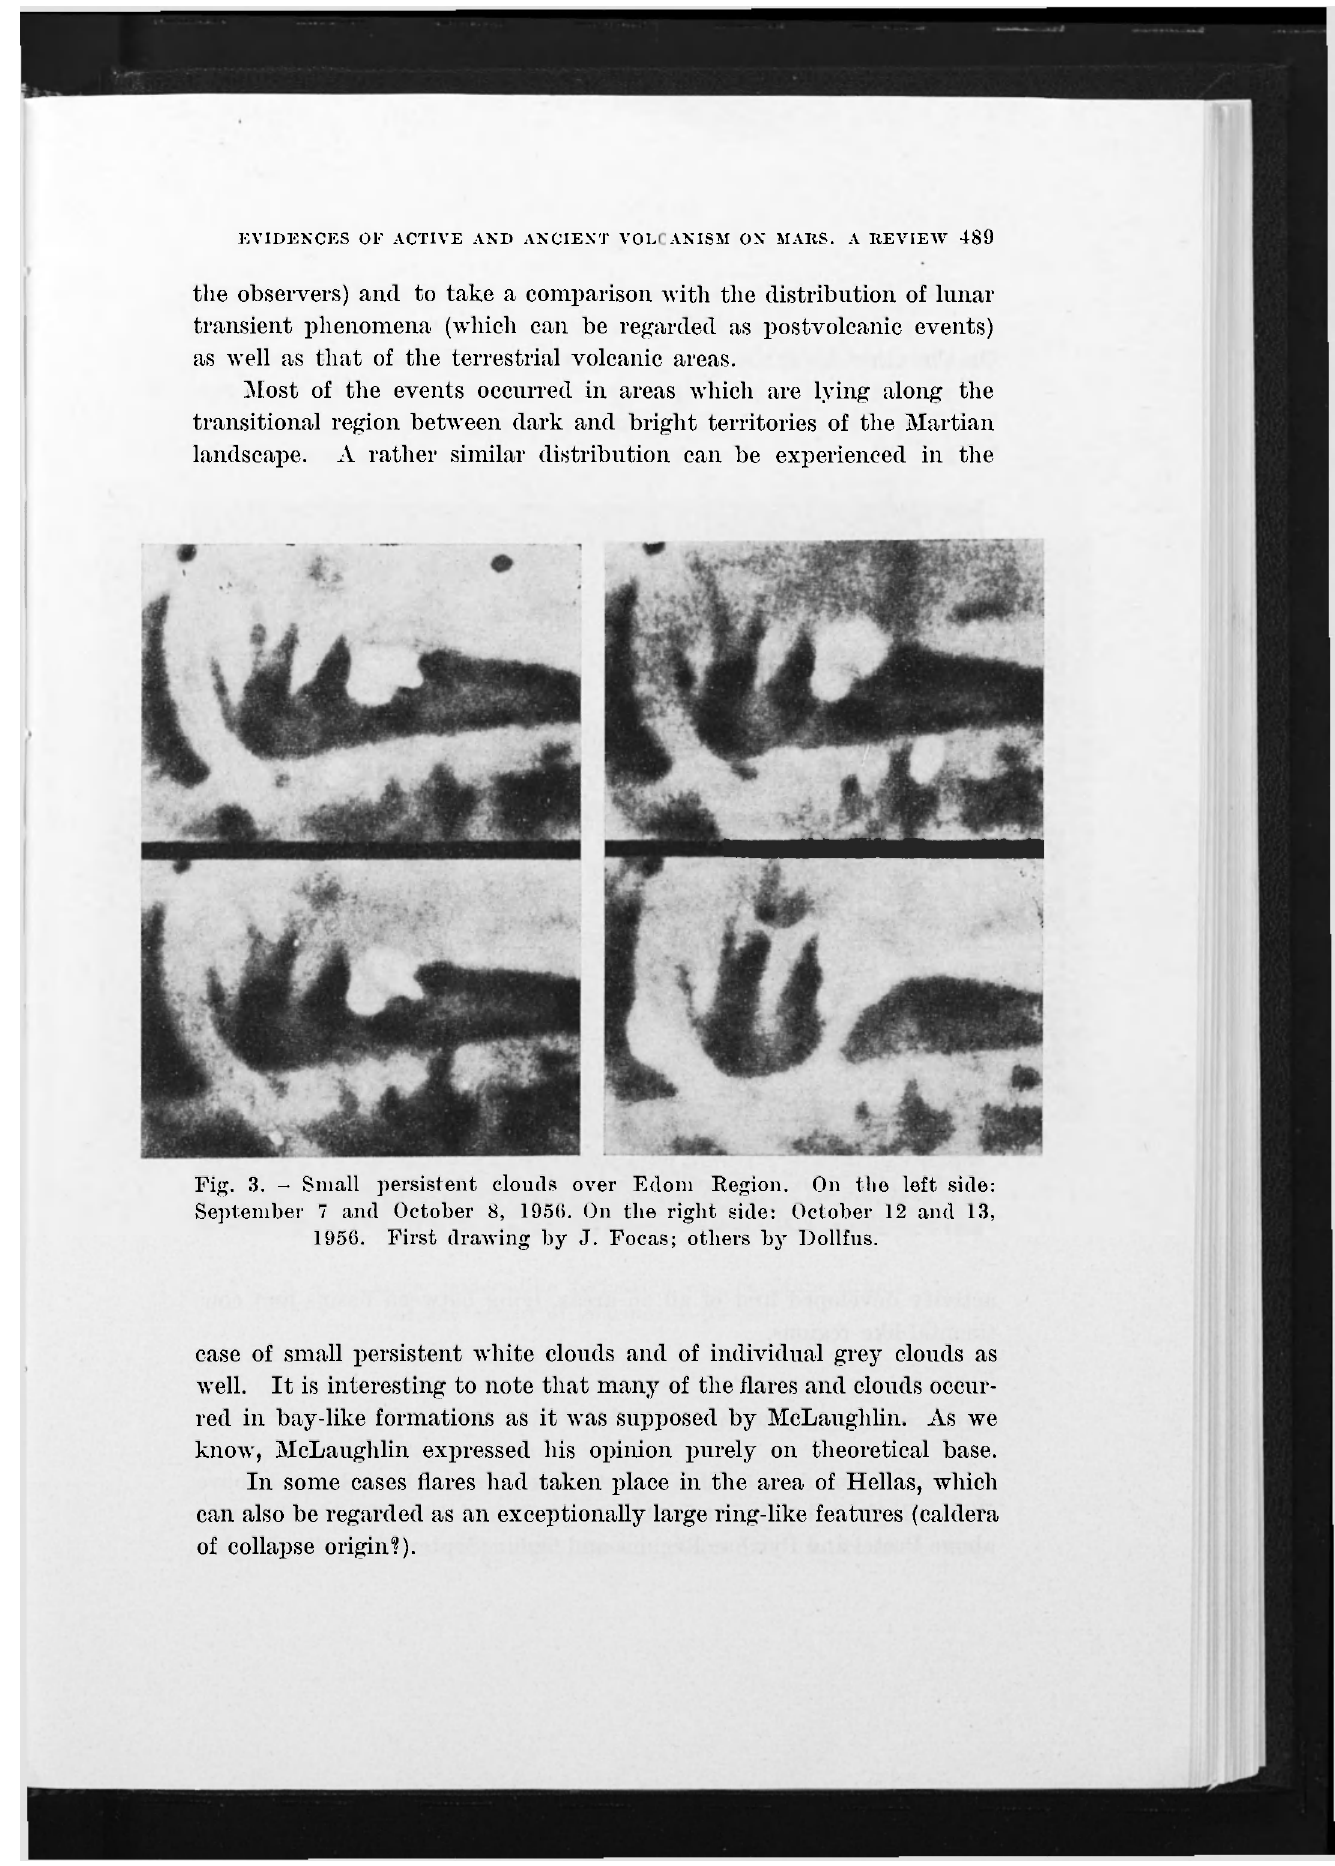
Fig. 3. - Small persistent clouds over Edom Region. On the left side: September 7 and October 8, 1956. On the right side: October 12 and 13, 1956. First drawing by J. Focas; others by